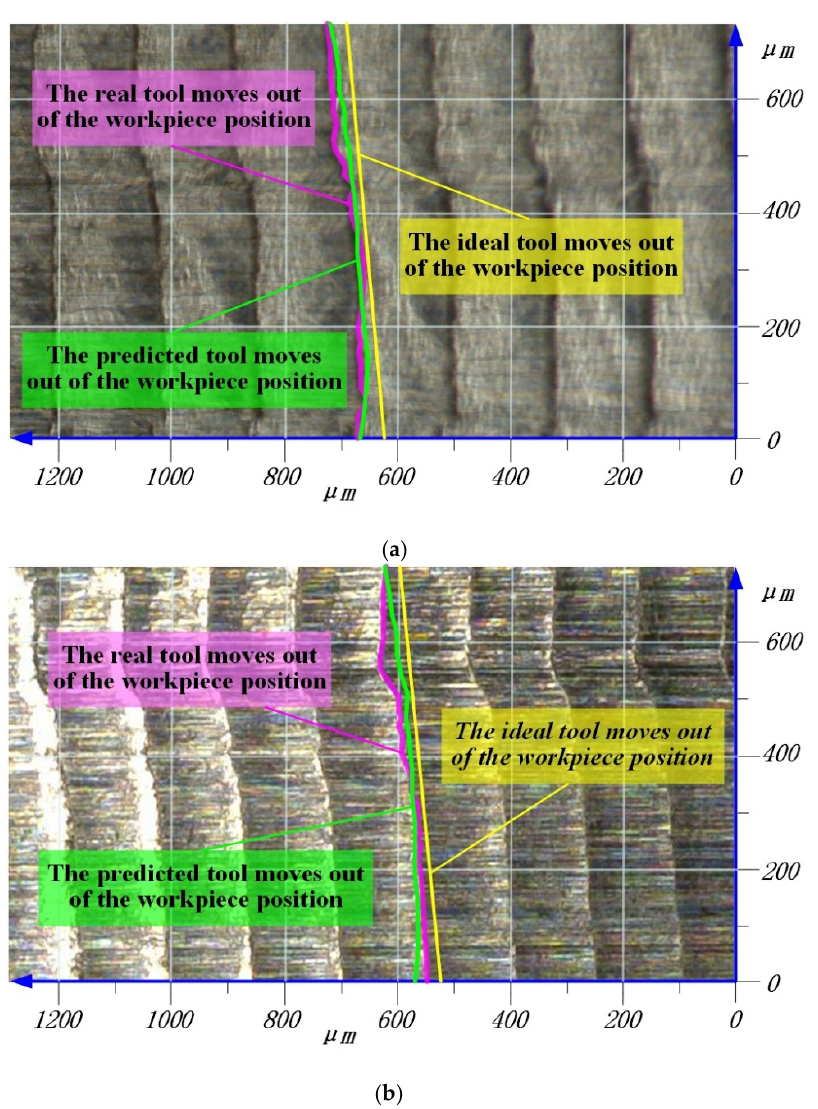
Figure 14. The tool moves out of the workpiece position in Table 2. ( a ) The 5th set of tools move out of the workpiece position. ( b ) The 6th set of tools move out of the workpiece position.